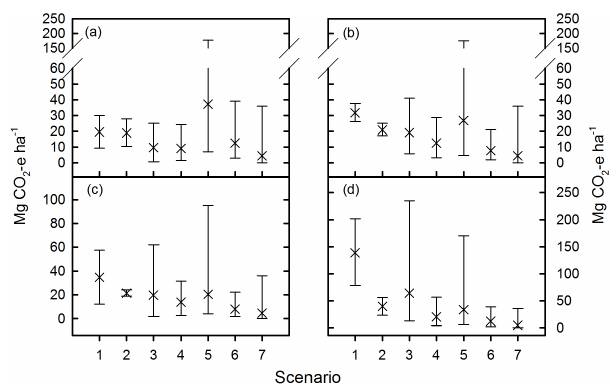
Figure 3. Estimates of equivalent CO 2 emissions from four for- est sites in East Gippsland, south-eastern Australia using Monte Carlo simulations of seven different scenarios. Sites are (a) Oliver, (b) Pettmans, (c) South Boundary and (d) Upper Tambo. See Ta- ble 1 for description of the seven scenarios. Crosses represent the median emission as determined by the Monte Carlo simulations ( n ≤ 71233). The error bars represent the 95% confidence intervals of the Monte Carlo